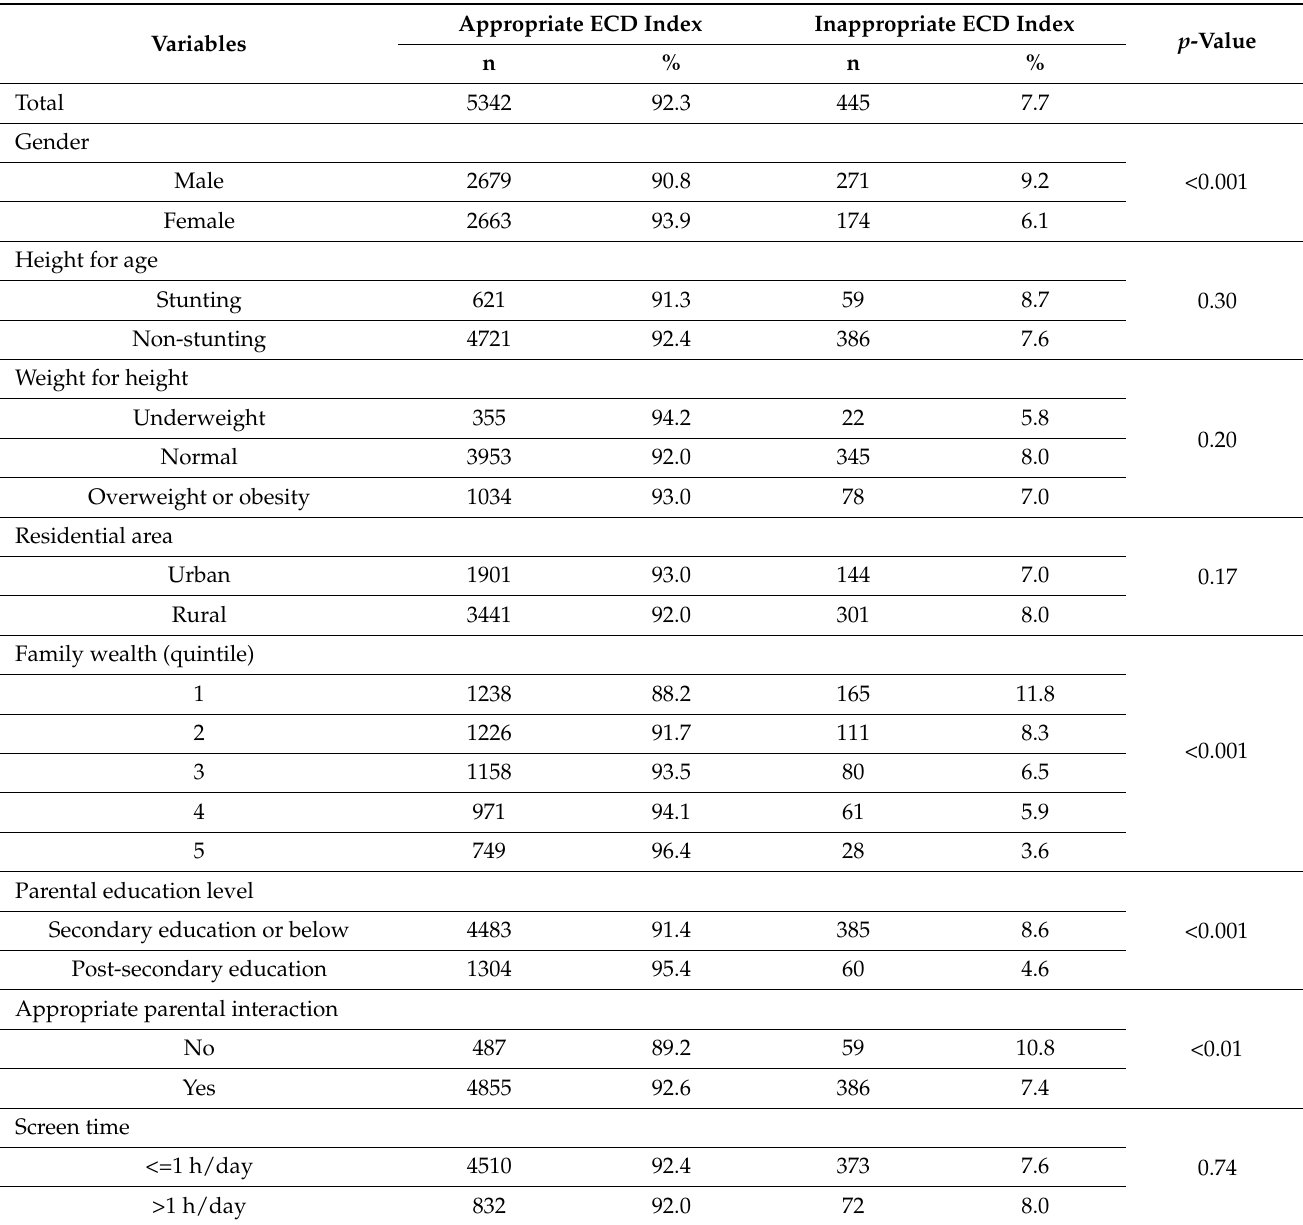
Table 2. Comparing the ECD index by children’s